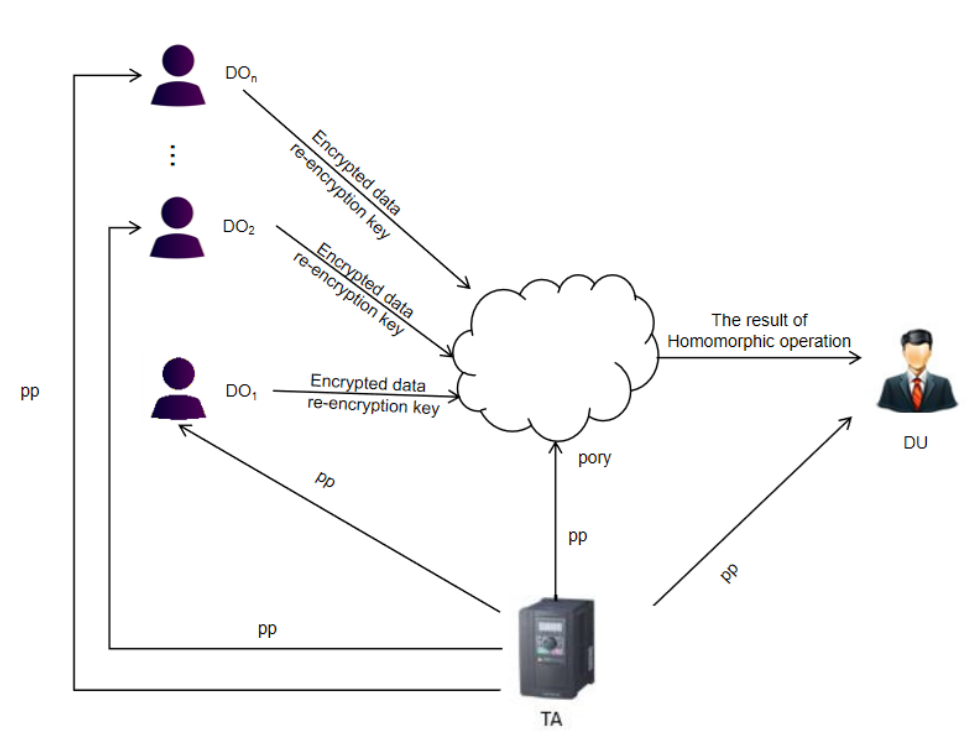
Figure 2. System model of the homomorphic proxy re-encryption (HPRE)